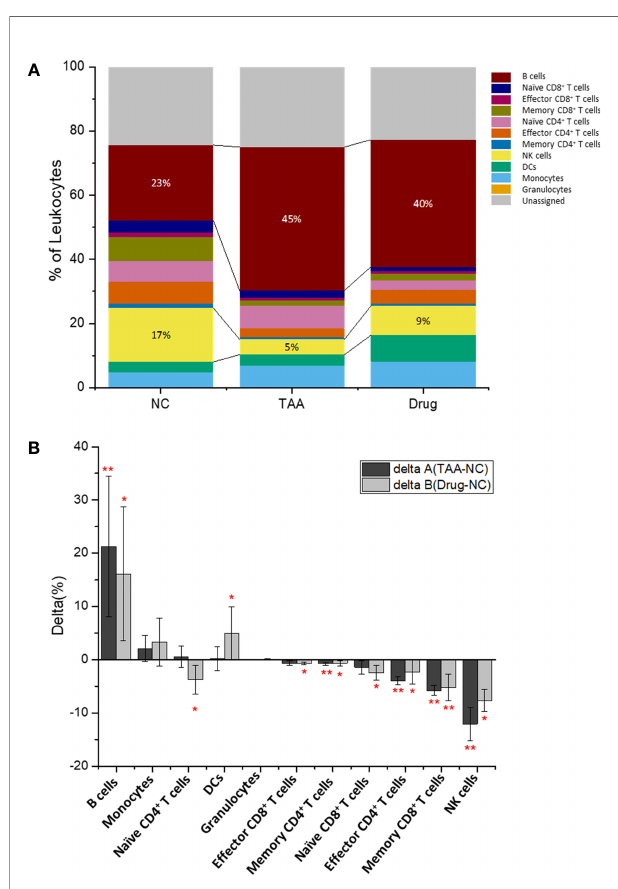
FIGURE 3 | Immune leukocytes population. (A) Population abundance (% of leukocytes) of the manually gated cell types of NC, TAA, and Drug groups. (B) Delta (%) calculation of delta A (TAA-NC) and delta B (Drug-NCC) by comparing and values. The statistical signi fi cant differences considered 0.01 < p < 0.05, and 0.001 < p have been annotated as * and **